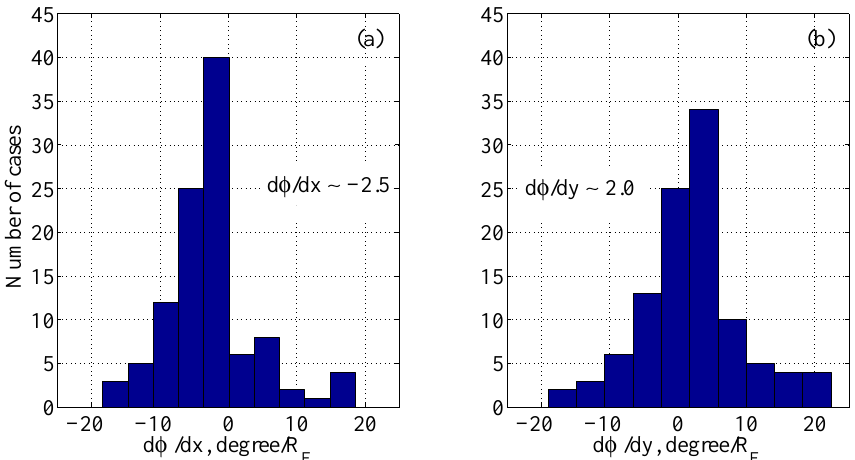
Figure 8. Gradients of the angle between the l vector and x axis: (a) d φ/ d x and (b) d φ/ d y .